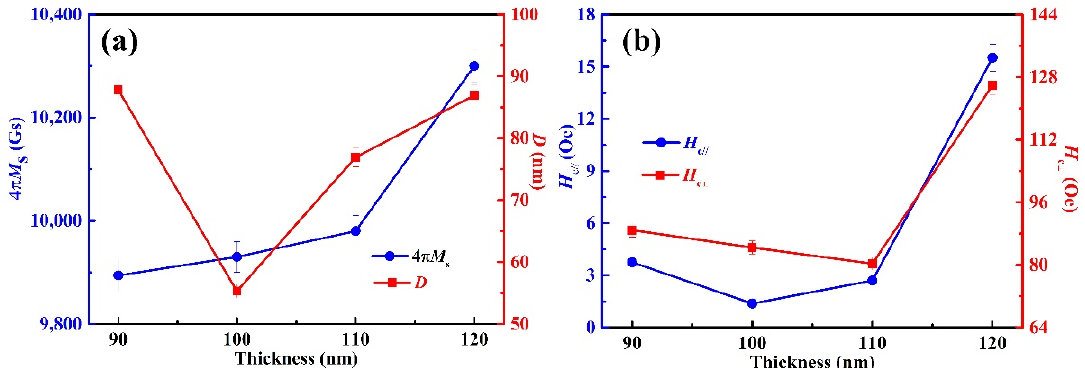
Figure 3. The static magnetic properties of the Ni 81 Fe 19 thin films with thicknesses from 90 to 120 nm: ( a ) the saturation magnetization (4 π M s ) and average grain size ( D ), ( b ) the in-plane ( H c// ) and out-of-plane ( H c ⊥ ) coercivity.